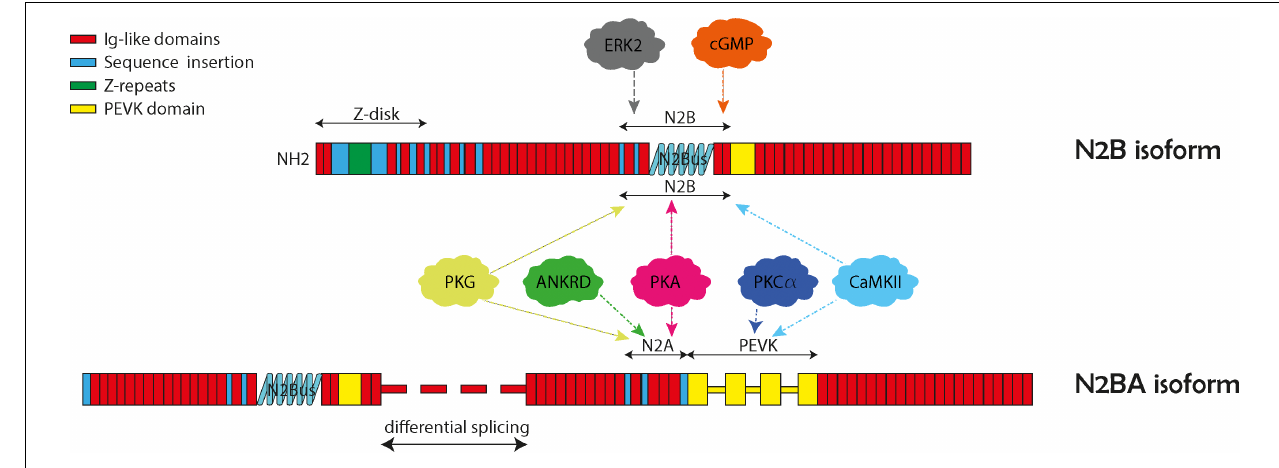
FIGURE 1 | Structure and domains of titin N2B and N2BA isoforms. The two cardiac isoforms and their protein kinase phosphorylation N2B and N2BA are illustrated here with their specific protein regions. Both isoforms contain the N2B unique sequence (N2Bus), and the PEVK region (titin region rich in proline, glutamate, valine, and lysine). The N2BA isoform also contains the N2A unique sequence (N2Aus). The various protein kinase binding partners are indicated in the balloons with arrows pointing to their general binding regions.